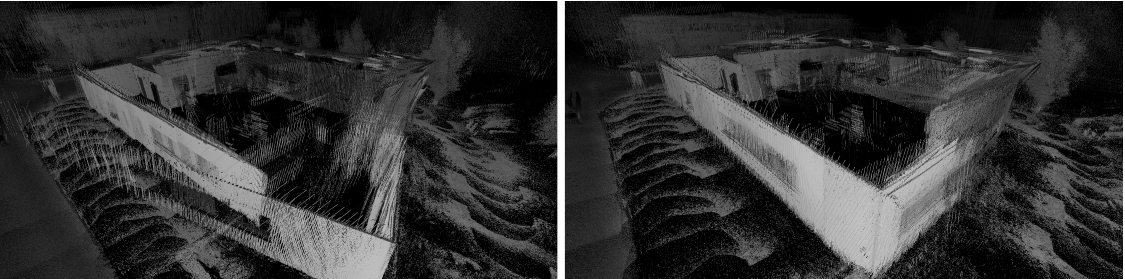
Figure 21. The walls on the left do match after optimization.